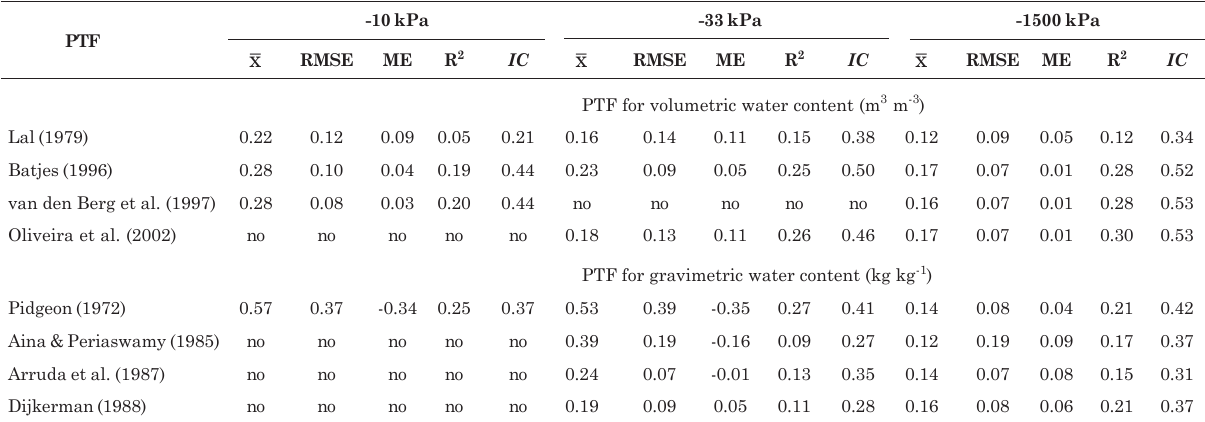
Table 6. Statistical indicators for the point PTFs for predicting volumetric or gravimetric water content. n = 67